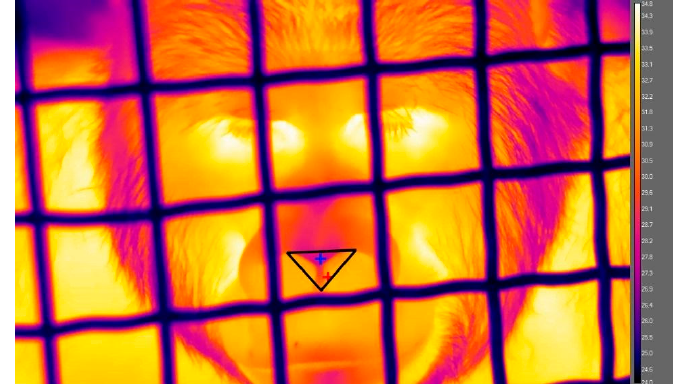
Figure 2. Example of a gorilla infrared thermography image. The black open triangle corresponds to the region of interest (ROI). The blue and red crosshairs inside the ROI correspond to the minimum and maximum temperatures, respectively. The color bar represents the surface temperature (°C).